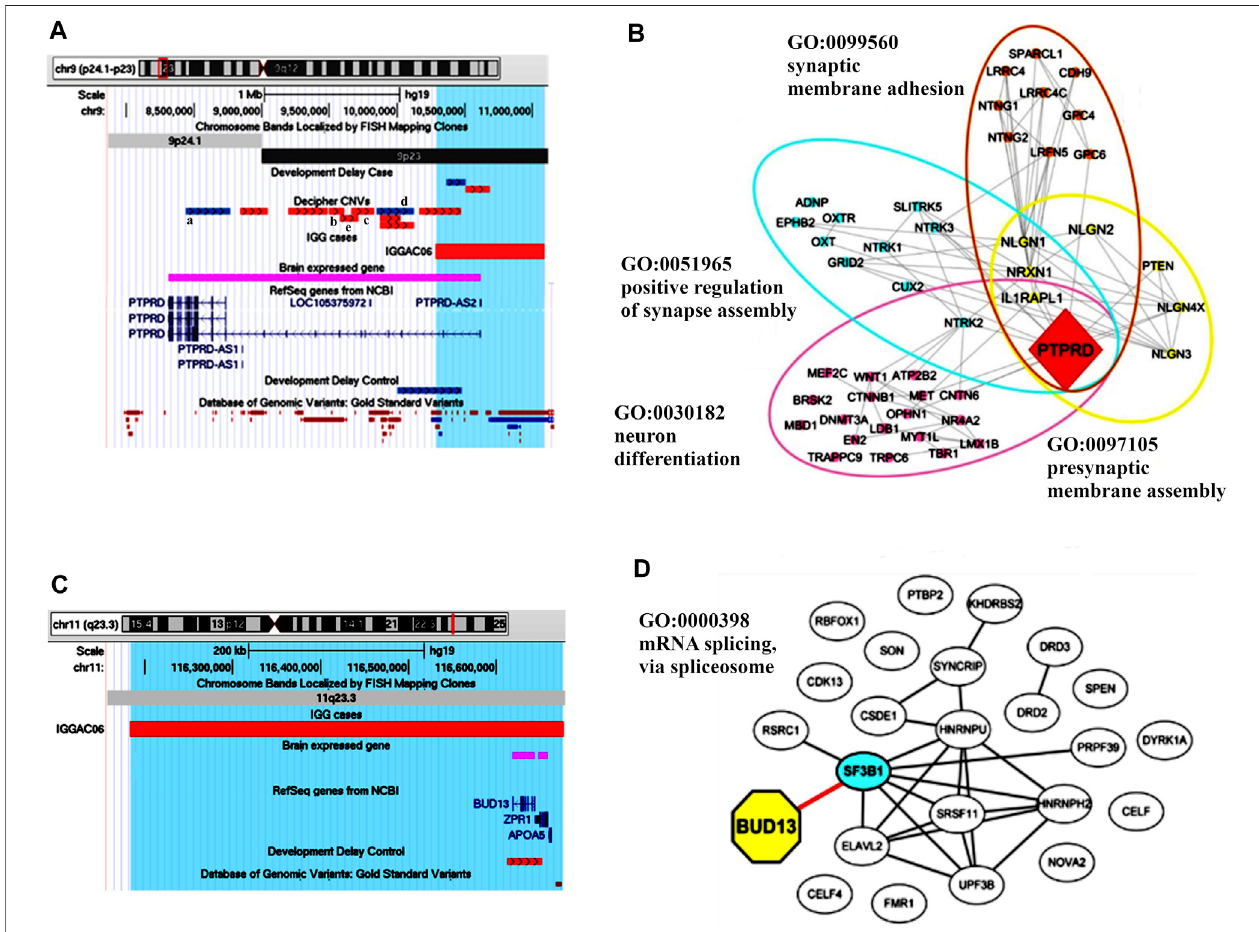
FIGURE 4 | Additive effects between PTPRD and BUD13 in patient IGGAC06. (A) Screenshot of chromosome 9 region overlapping the deletion of patient IGGAC06 (red bar, chr9:10,286,927-11,086,155). Decipher CNVs (a: intragenic duplication in patient 333436; b: deletion in patient 412118; c: deletion in patient 337260; d: intragenic duplication in patient 260089 and e: deletion in patient 279686). (B) The network depicts the protein-protein interactions (grey lines) revealed by STRINGanalysis(visualized byCytoscapetool)onthebasisoftheenrichmentobtainedwithGeneCodis4tool.TheFigureshowstheenriched GOtermsclustering the candidate gene PTPRD and known NDD genes. (C) Screenshot of chromosome 11 region overlapping the deletion of patient IGGAC06 (red bar, chr11: 116,182,875-116,677,043). (D) The network depicts the protein-protein interactions (grey lines) and experimentally determined interaction with a SFARI gene (red line) revealed by STRING analysis (visualized by Cytoscape tool) on the basis of the GO term “ mRNA splicing via spliceosome ” . The network indicates a direct interaction of BUD13 with the known NDD gene SF3B1 .